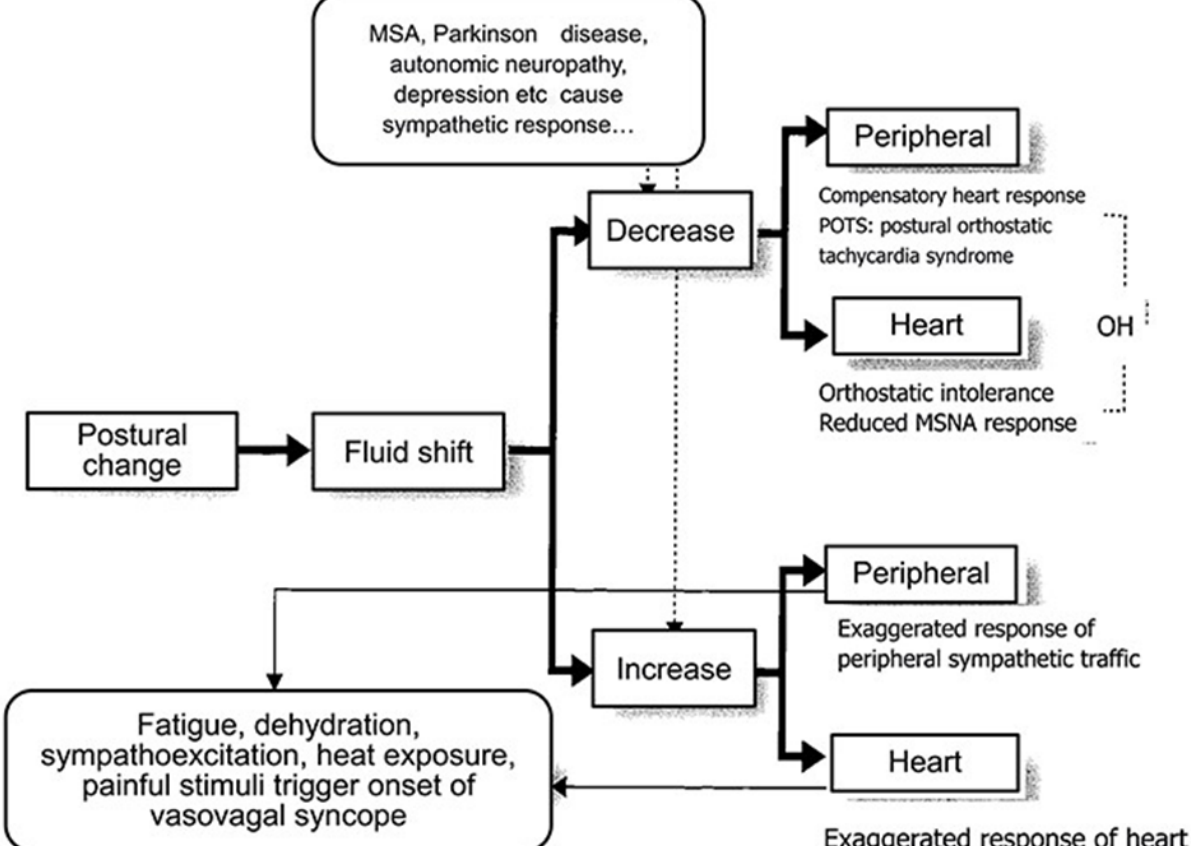
Figure 1. The CMO-EMPHA emergency cardiac rescue process. MSA: multiple system atrophy; MSNA: muscle sympathetic nerve activity; OH: orthostatic